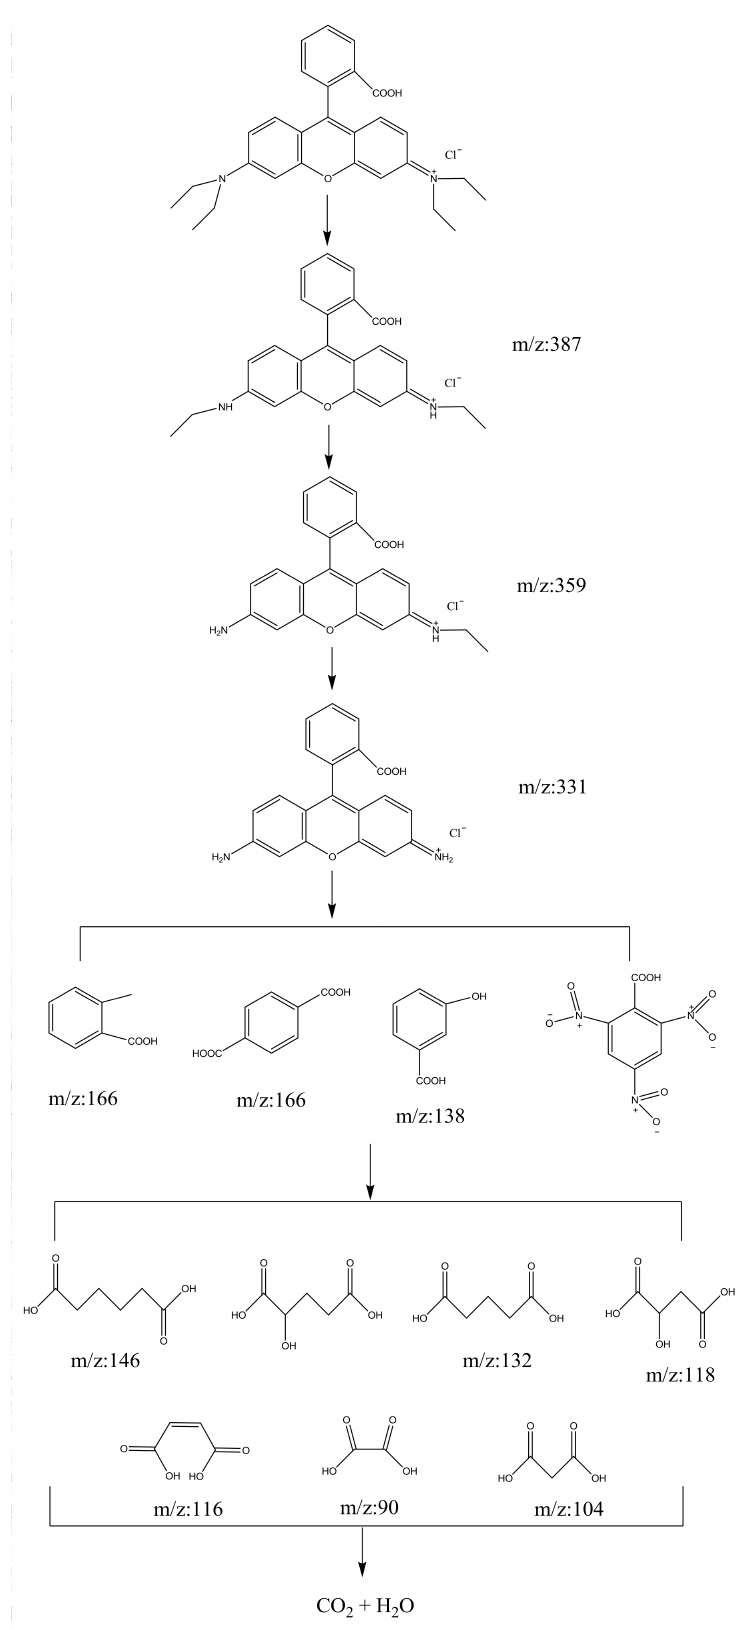
Figure 12. Conceivable photodegradation pathway of RhB under simulated sunlight irradiation with BiSnSbO 6 as